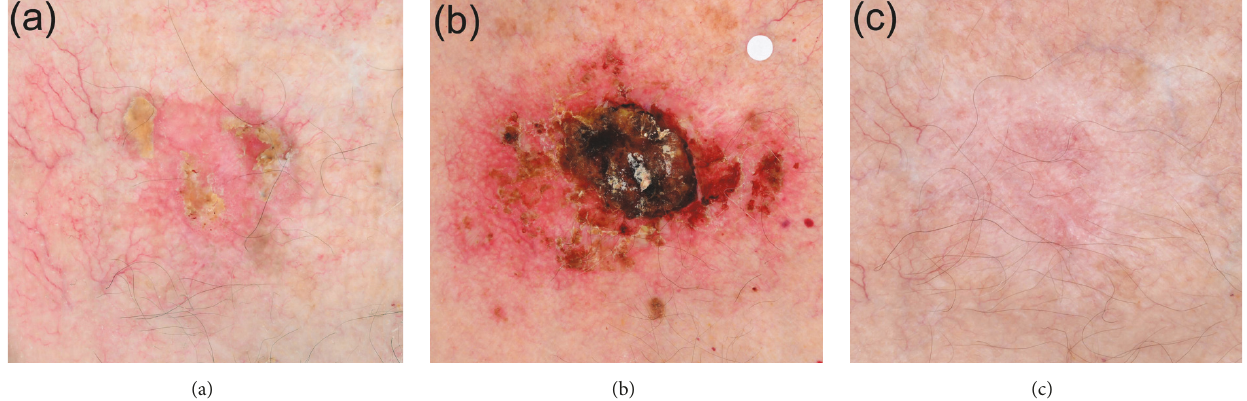
Figure 1: A 33 mm Bowen’s disease lesion of the sternum (Patient 4). Cross-polarized photography is applied to enhance the visualization of the vascular pattern. Panel (a): the lesion at baseline. Panel (b): the area of the lesion at day 7 of treatment (one week after treatment onset with cryosurgery at day 0 and 4 daily applications of ingenol mebutate in days 0-3 of treatment). The white label is included for calibration purposes. Panel (c): the site of the lesion at 12 months follow-up. A slightly hypopigmented shallow scar is evident with excellent skin healing (hair follicle preservation) in a skin location of overall problematic healing features (sternum).